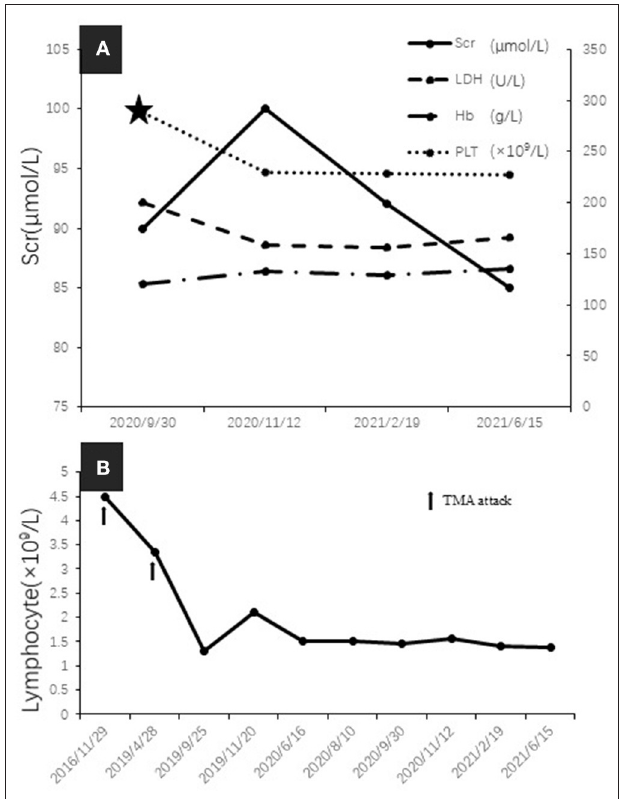
FIGURE 4 | (A) Serum creatinine (Scr), lactate dehydrogenase (LDH), hemoglobin, and platelet count over time during remission (five-pointed star indicated the commencing date of Ibrutinib treatment). (B) The change of peripheral blood lymphocyte count (arrows indicated TMA